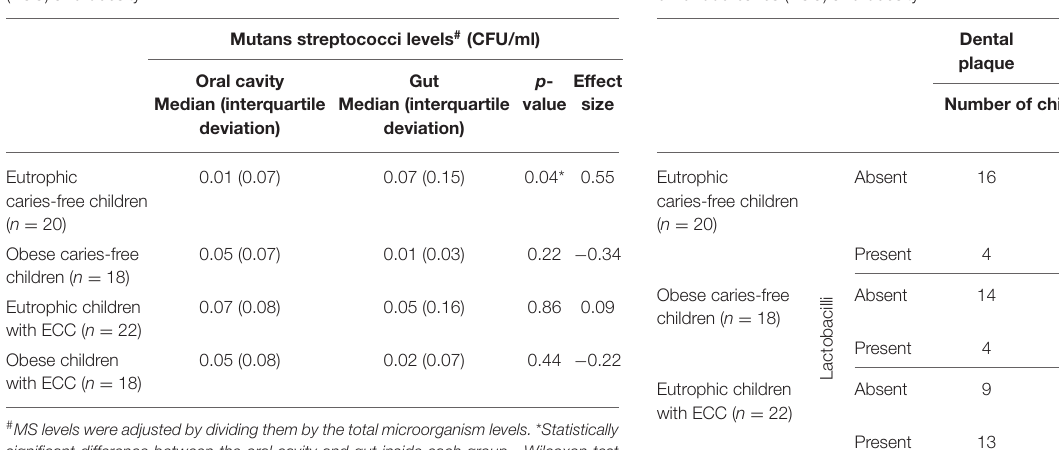
TABLE 3 | Presence or absence of lactobacilli in the oral cavity compared with that in the lower gastrointestinal tract of preschoolers, with respect to early childhood caries (ECC) and